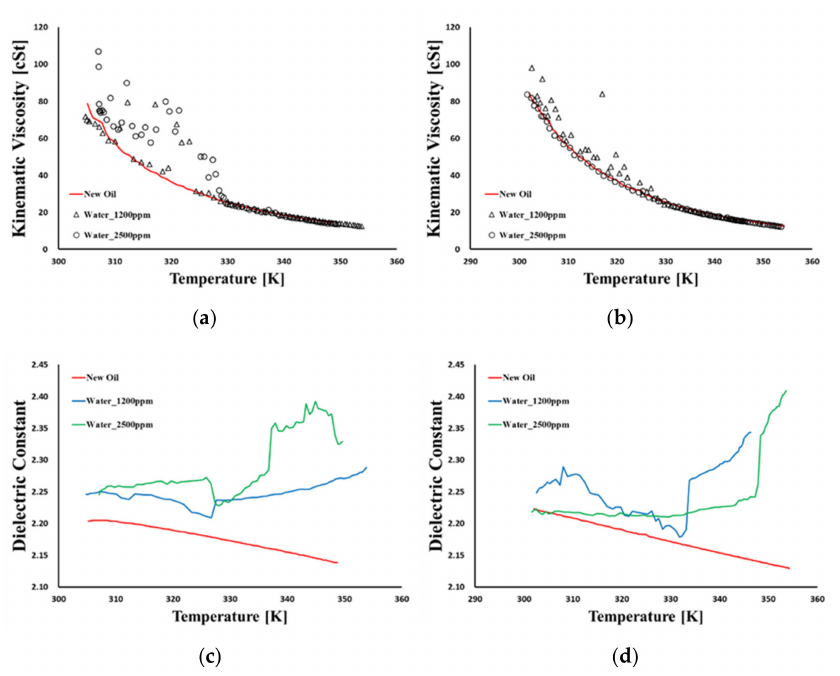
Figure 7. The oil sensor signal of water contamination. ( a ) Sensor A of kinematic viscosity. ( b ) Sensor